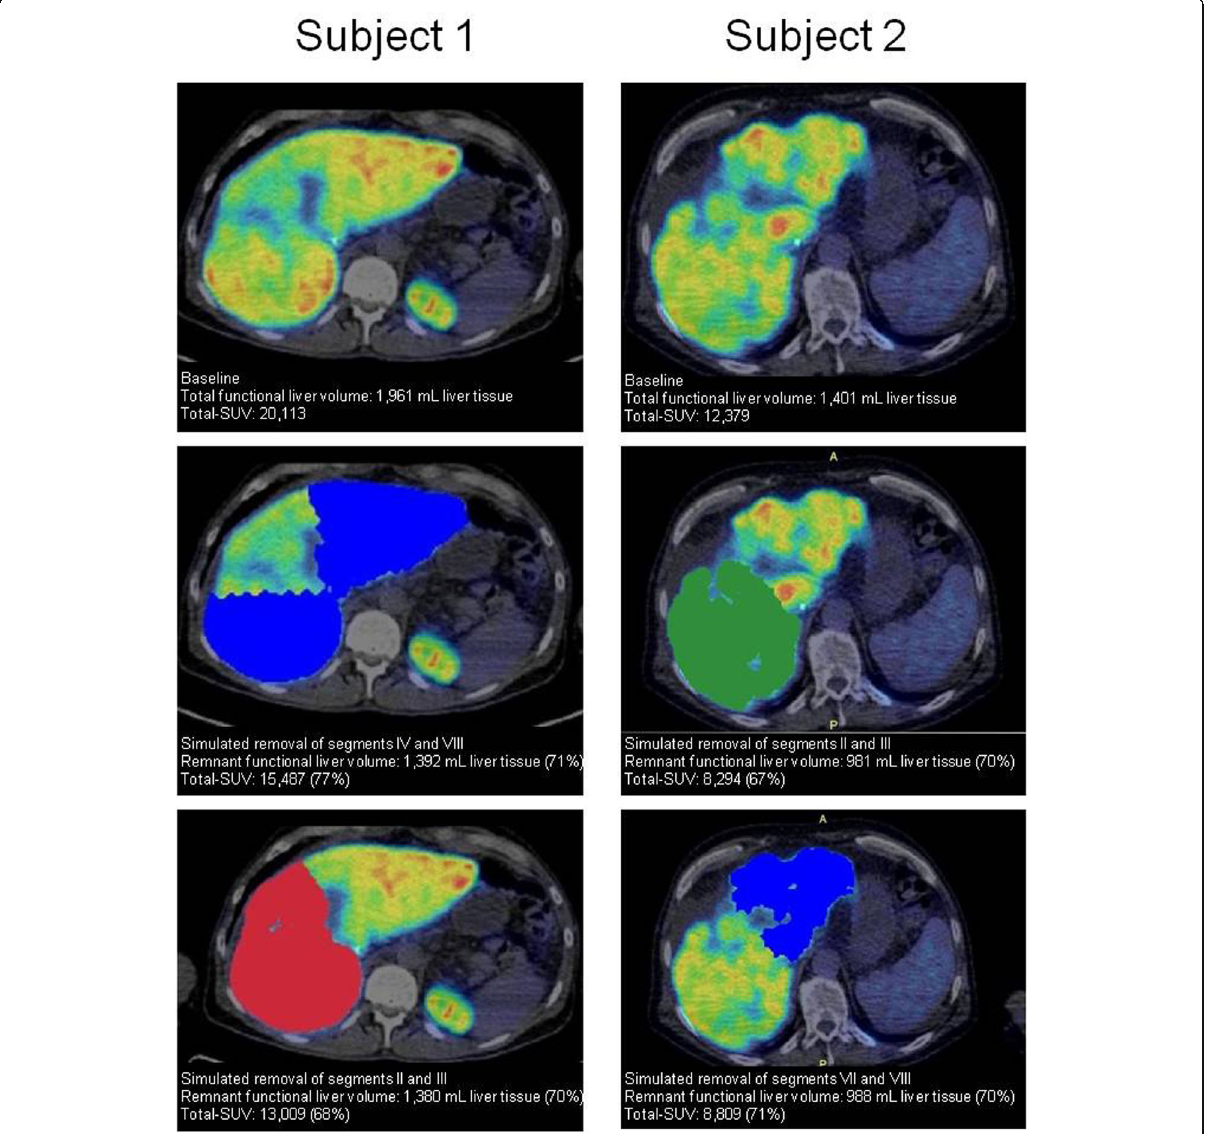
Fig. 4 Effect on remnant functional liver volume and total SUV of 18 F-FDGal by simulated resections of 30% of total functional liver volume in two patients with cirrhosis. The effect is calculated in percentage of baseline